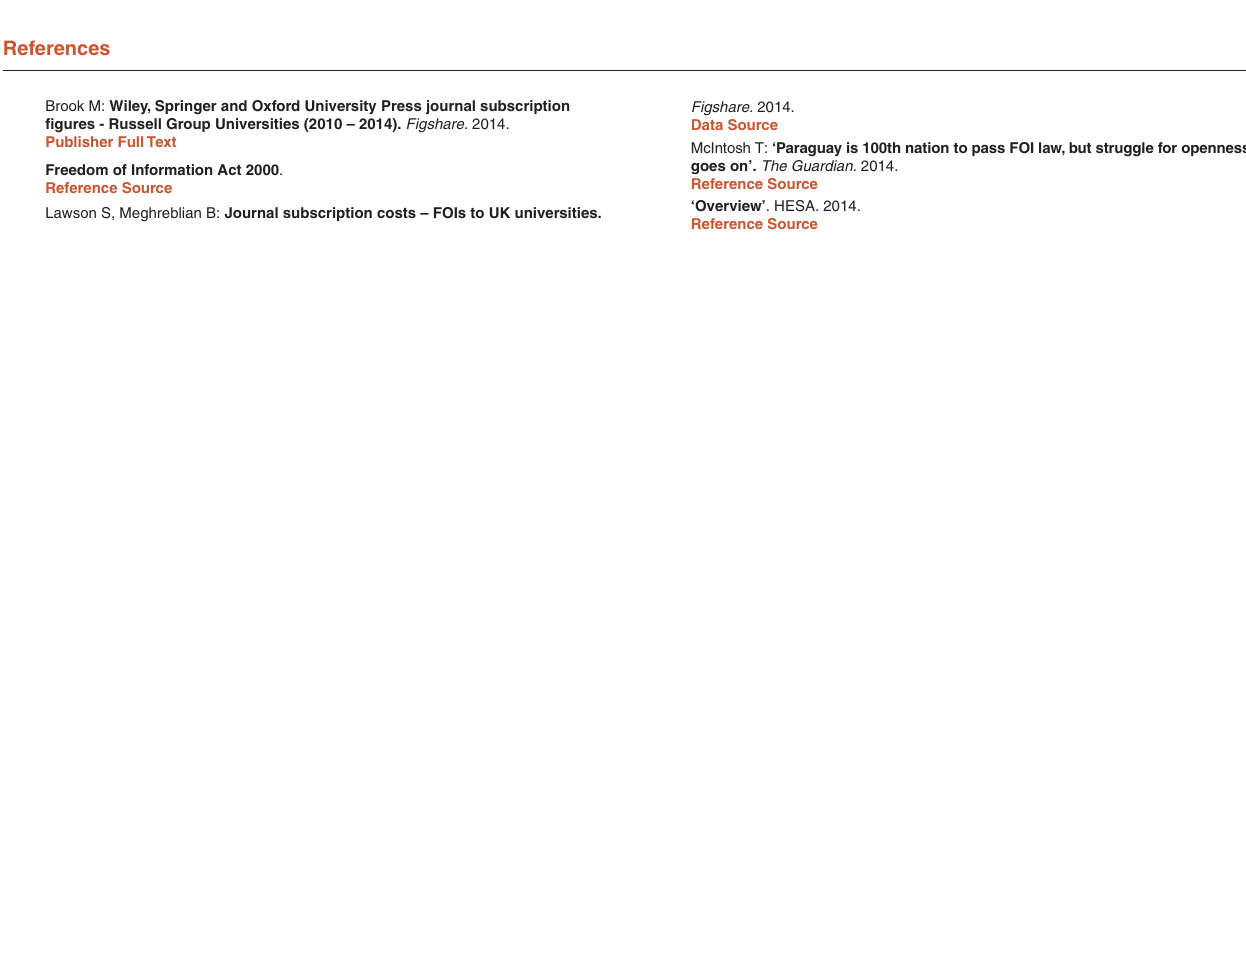
Figshare. 2014. Data Source McIntosh T: ‘Paraguay is 100th nation to pass FOI law, but struggle for openness goes on’. The Guardian. 2014. Reference Source ‘Overview’ . HESA.